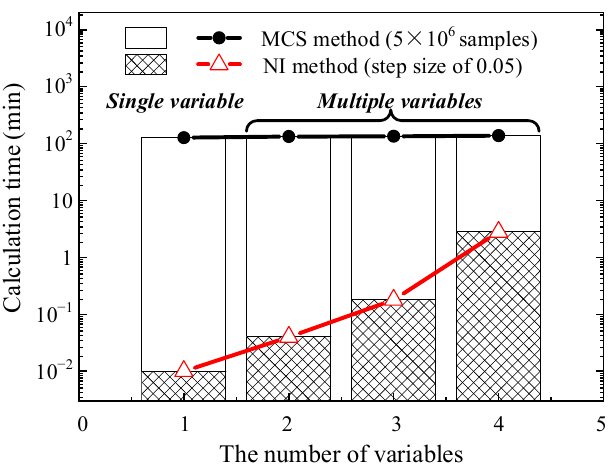
Figure 19 . Time costs of different methods with different numbers of random variables [48]. Figure 19. Time costs of different methods with different numbers of random variables